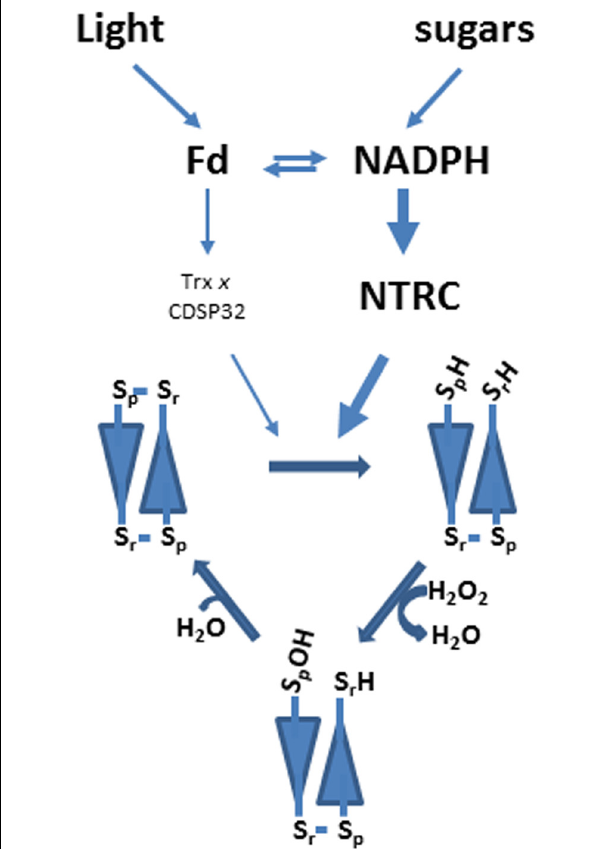
FIGURE 1 | Reaction mechanism and pathways for 2-Cys Prx reduction in chloroplasts. Typical 2-Cys Prxs are homodimeric enzymes arranged in head-to-tail conformation. Catalysis is performed by two cysteine residues, peroxidatic ( S p ) and resolving ( S r ).The peroxidatic cysteine reacts with hydrogen peroxide producing a molecule of water and becoming oxidized as sulfenic acid. In a second step the resolving cysteine condenses with the sulfenic acid intermediate so that a molecule of water is produced and both cysteines are linked by a disulfide bridge. For a new catalytic cycle the disulfide has to be reduced. In plant chloroplasts both in vitro and in vivo analyses suggest that NTRC is more relevant for 2-Cys Prx reduction than other plastidialTrxs such as CDSP32 andTrx x